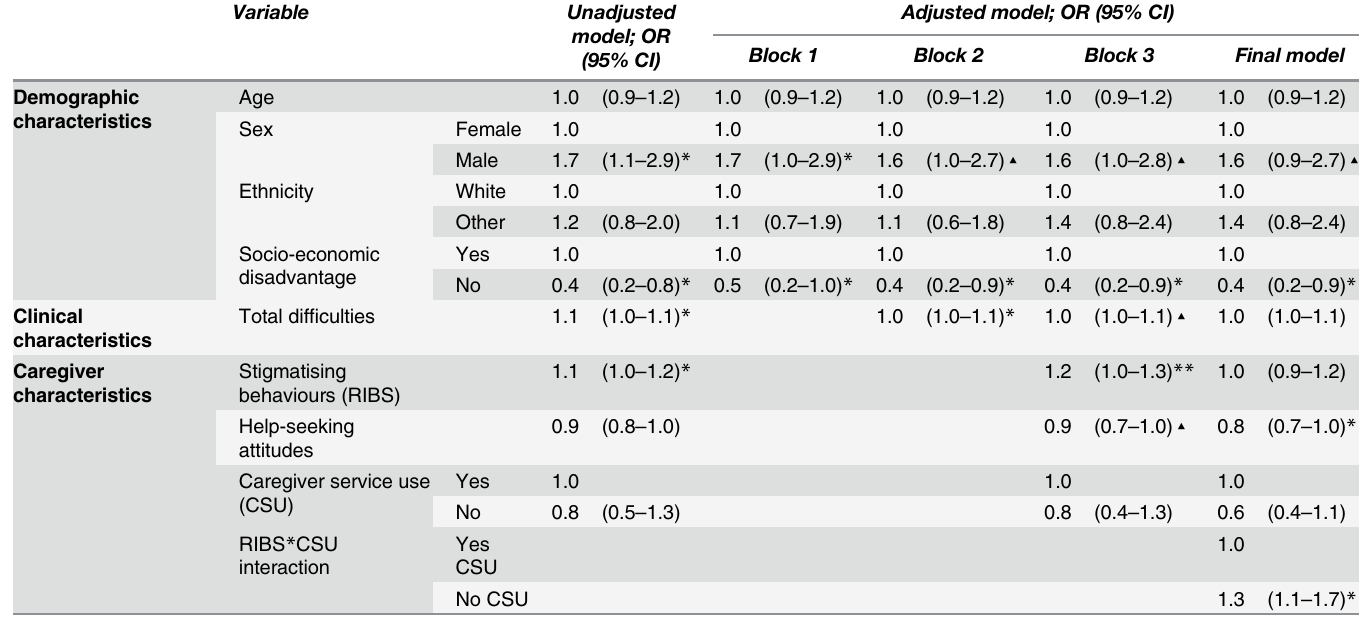
Table 3. Unadjusted and adjusted odds ratios (ORs) and 95% confidence intervals (CIs) for factors associated with young people ’ s service use across health care and education settings.